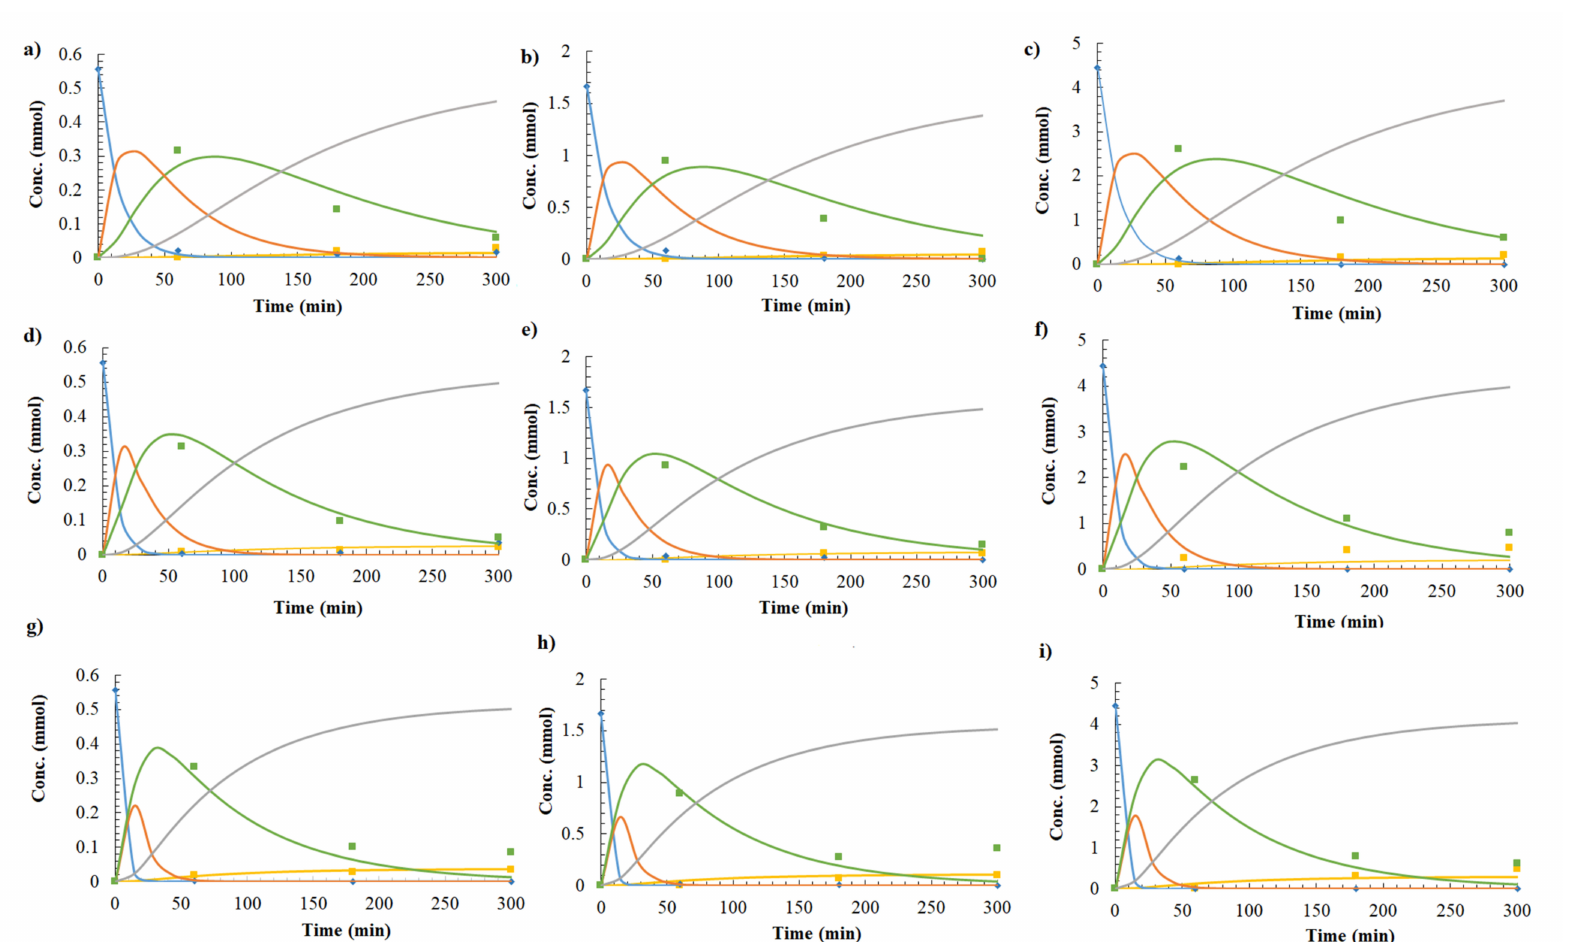
Figure 3. Kinetic model fit (lines) to the individually obtained experimental data. Typical time–concentration profile of the products of acid-catalyzed fructose dehydration at ( a – c ) 140 ◦ C, ( d – f ) 150 ◦ C, and ( g – i ) 160 ◦ C for 100, 300, and 800 mg using CH heating with 3 mL solvent, 10 mg MIL-101(Cr)-SO 3 H(3), and 100 mg fructose (0.56 mmol). Symbols denote experimental values: ( (cid:4) , — ) fructose conversion, ( — ) intermediate formation, ( (cid:4) , — ) 5-HMF production, ( (cid:4) , — ) LA + FA production, ( — ) side product